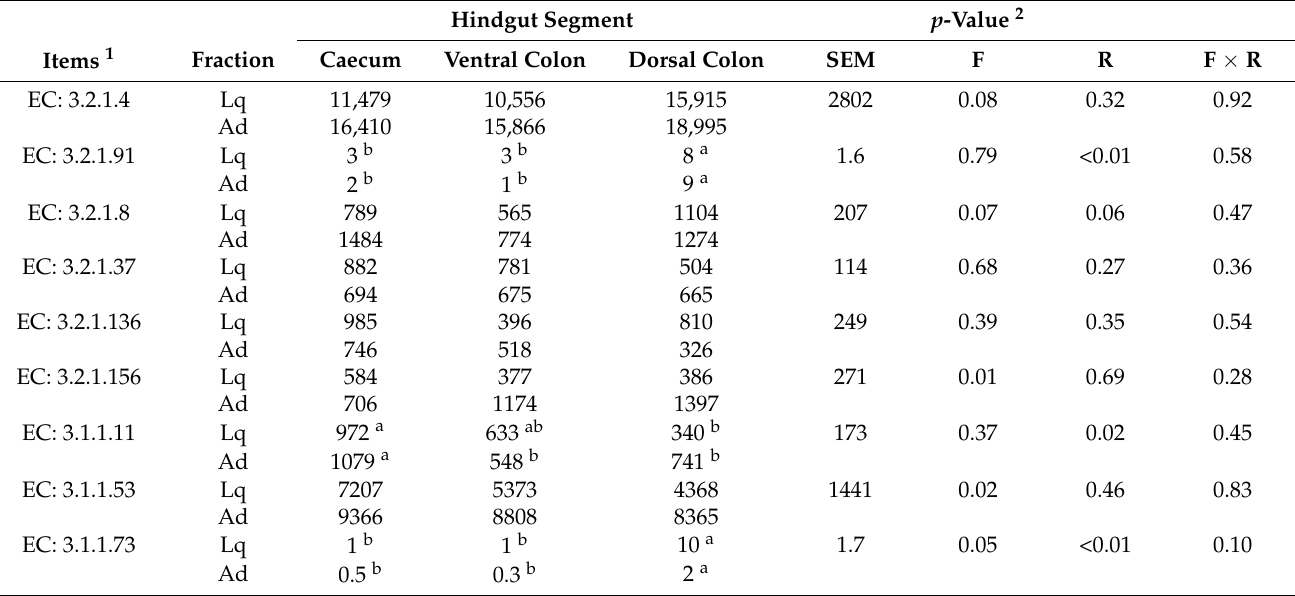
Table 5. The abundance of enzymes related to plant cell wall breakdown predicted by phylogenetic investigation of communities by reconstruction of unobserved states (PICRUSt). Hindgut Segment p -Value